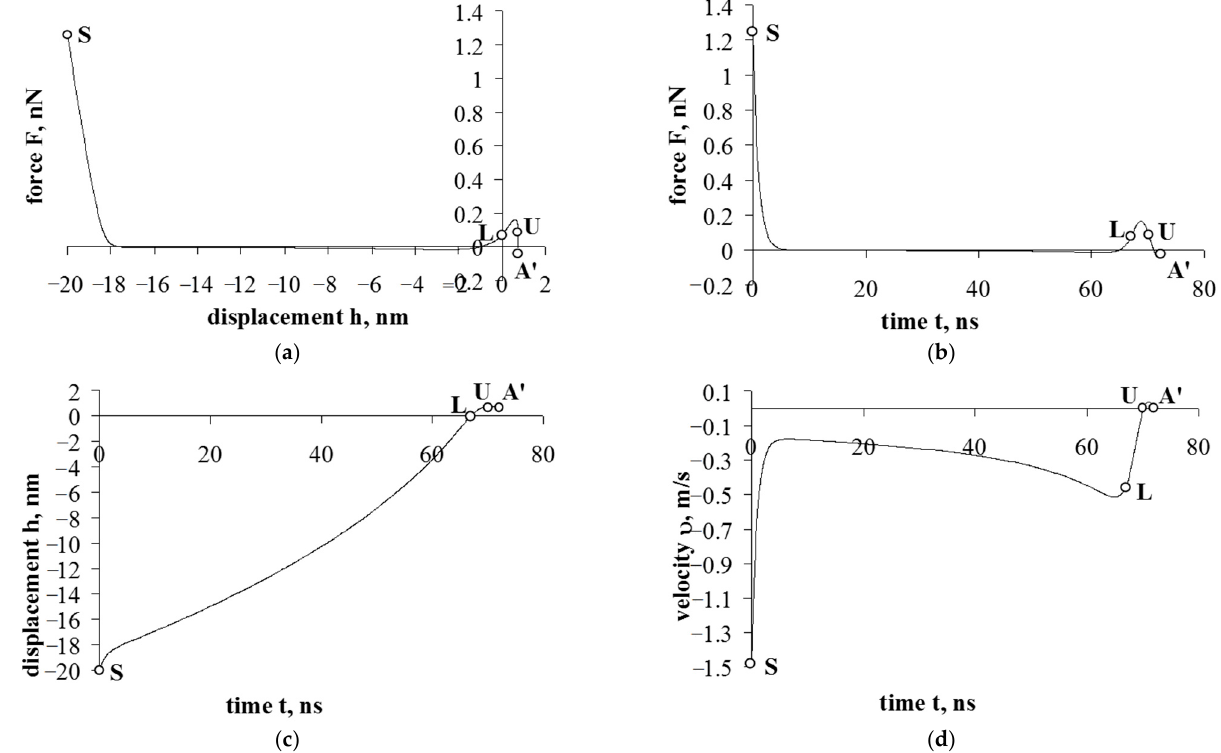
Figure 5. Particle interaction in alveolus. Particle diameter: 100 nm. ( a ) normal force F versus displacement h; ( b – d ) history of normal force F, displacement h, velocity υ , respectively. Table 2. Particle interaction properties during interaction at certain points S-L-U-A’.